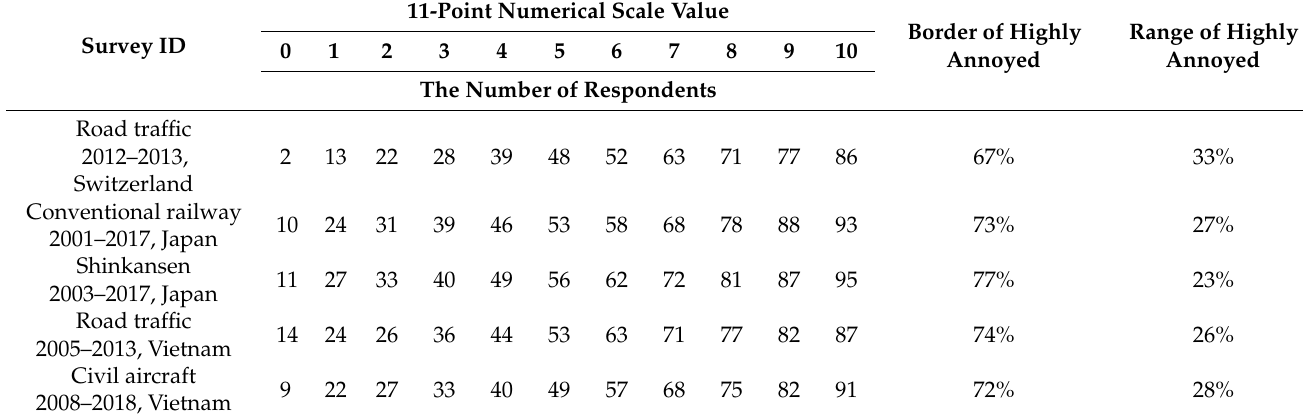
Table 11. Frequency-weighted average of discrete values of the 5-point verbal scale score on the 11-point numerical scale.